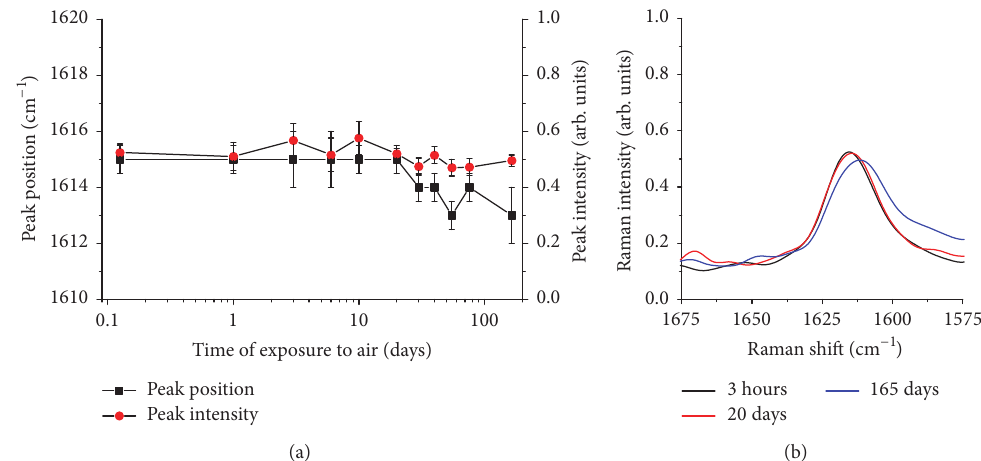
Figure 6: (a) Position (black squares) and intensity (red circles) of the Raman peak at about 1615 cm −1 for HKUST-1 as a function of time of exposure to air moisture. (b) Raman spectra in the region of the peak at about 1615 cm −1 acquired for HKUST-1 after 3 hours, 20 days, and 165 days of exposure to air